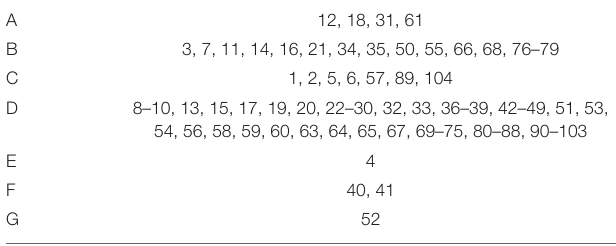
TABLE 1 | Current spectrum of known